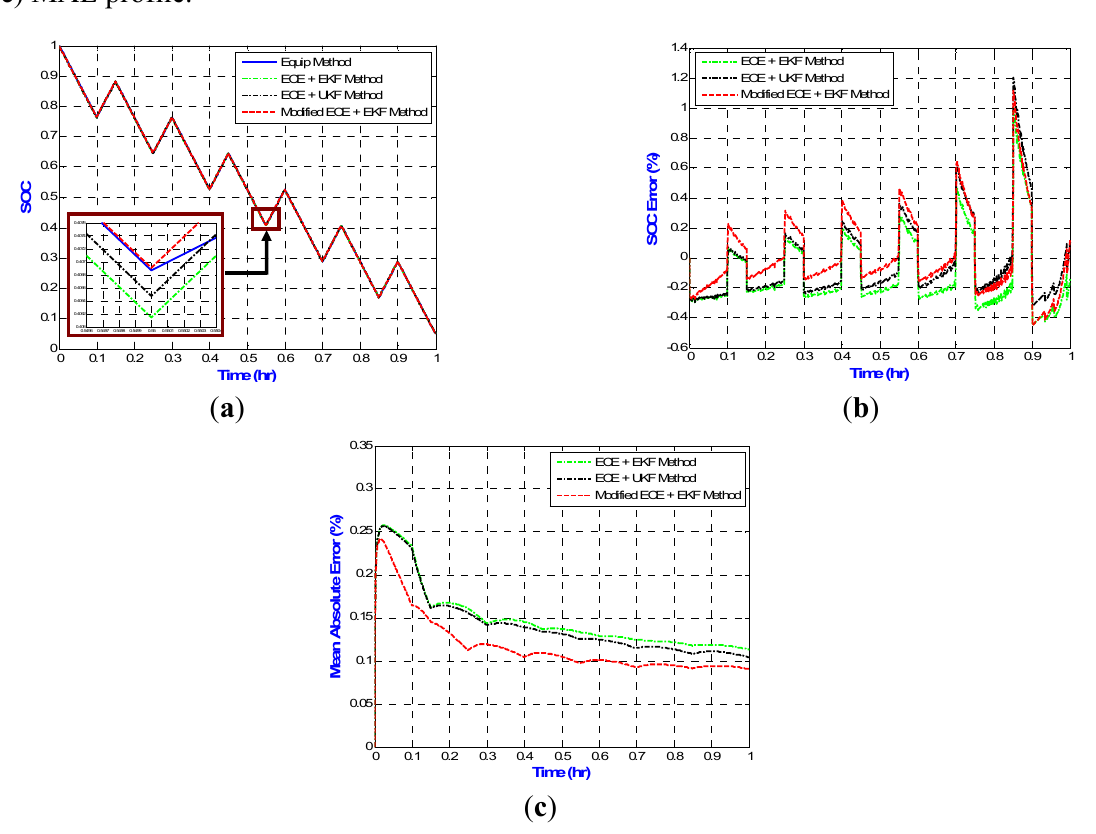
Figure 12. SOC estimation in Experiment I ( a ) SOC profile; ( b ) SOC error profile; ( c ) MAE profile.